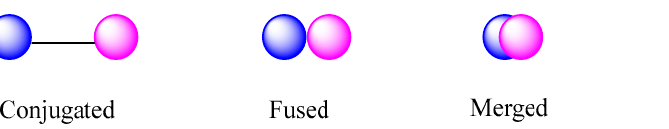
Figure 4. Classi fi cation of hybrids based their structure according to Morphy and Rankovic, adapted from [71]. from